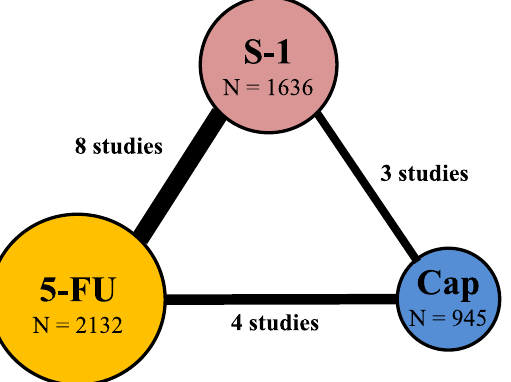
Figure 2. The network meta-analysis. Studies that contained 5-FU, capecitabine or S-1 based regimens with an equal backbone were analysed in a 3-node network. The size of each node corresponds to the number of patients that were randomized to receive S-1 (n = 1636), capecitabine (n = 945) and 5-FU based therapy (n = 2132). The lines connect the regimens that were directly compared in head-to-head RCTs. The thickness of the lines corresponds to the number of RCTs. Abbreviations: 5-FU: